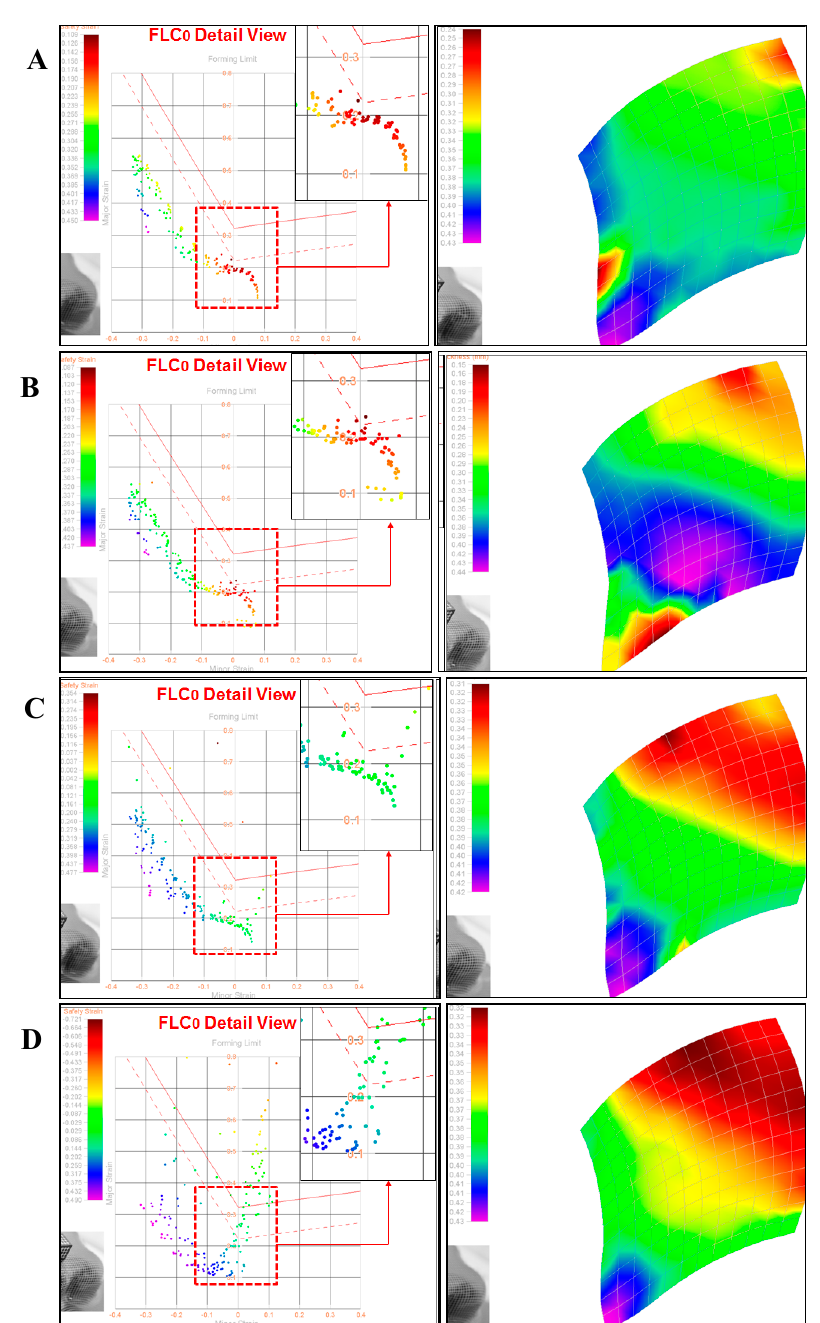
Figure 12. ASAME strain signature for UV-cured PUA coating films: Result of the sample ( A ) P-IBOA, ( B ) P-IBOMA, ( C ) P-TPGDA, and ( D ) Result of sample P-HDDA for draw depth 40 mm. Table 3. LPH & Reduction thickness by Cross-die cup drawing for UV-cured PUA coating films. Coating System No Sample Thickness Condition 1